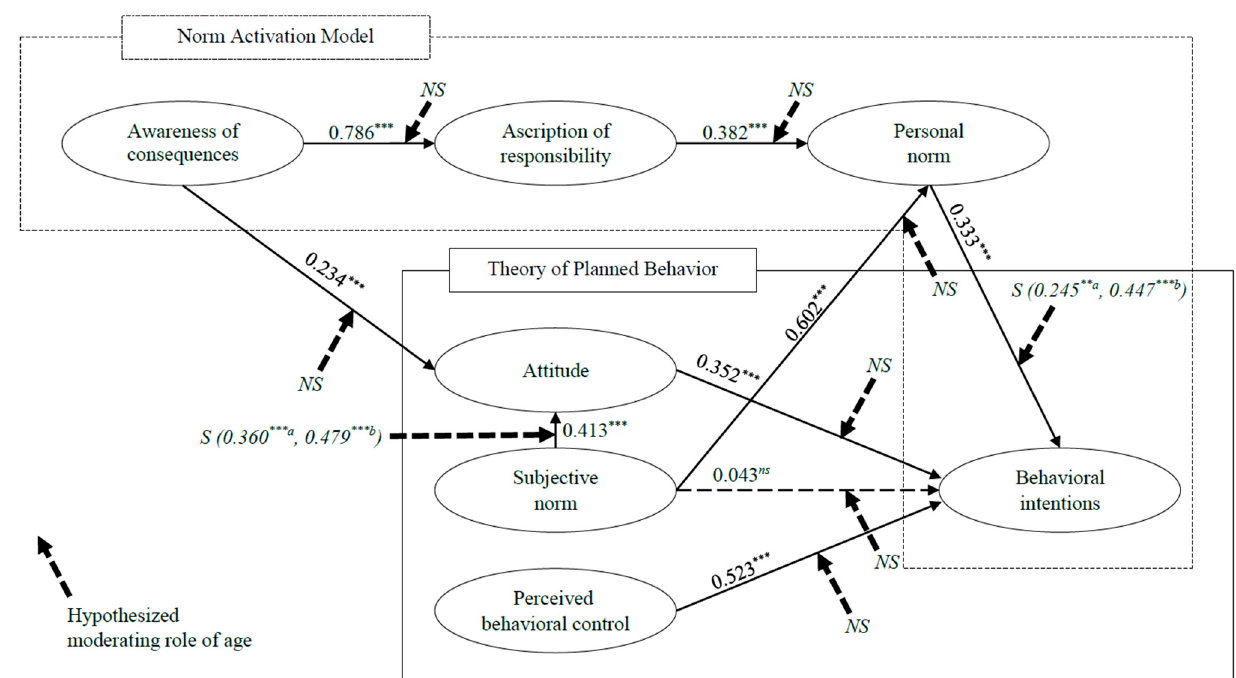
Figure 2. Standardized theoretical path coefficients. Notes 1: ** p < 0.01, *** p < 0.001, and ns not supported. Notes. 2: S = supported and NS = not supported. Notes 3: a path coefficient for a low age group and b path coefficient for a high age group.